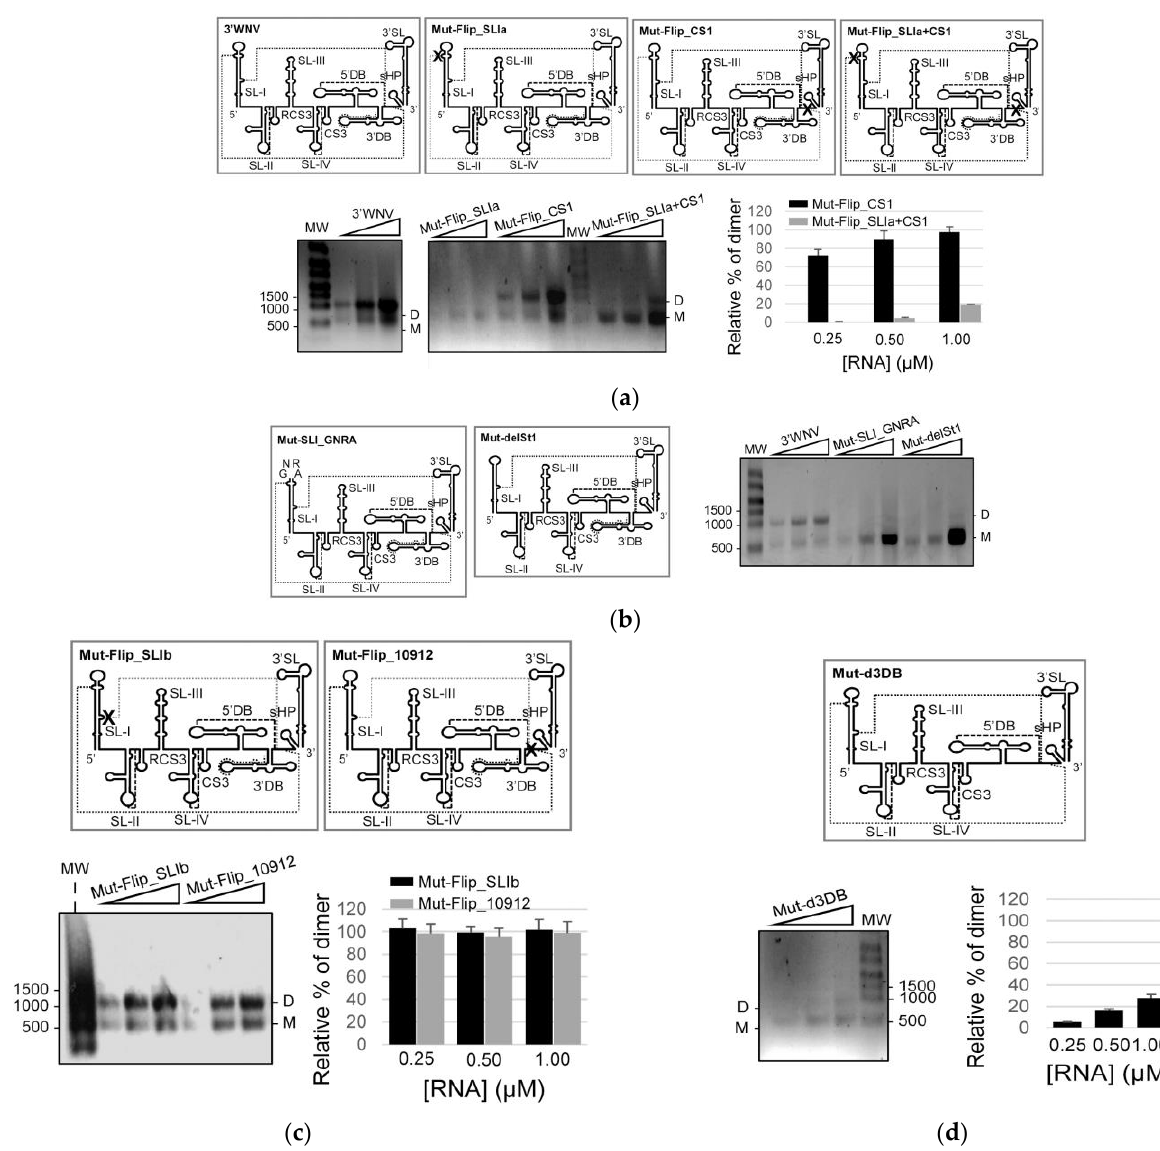
Figure 5. Specific sequences within the SL-I and the 3 ′ DB elements are involved in the formation of dimeric conformers. A collection of mutants bearing different sequence variations in SL-I ( a , b ), the single-stranded region placed at the 3 ′ end of the double-dumbbell elements ( c ) and the 3 ′ DB ( d ) were generated and monitored for their capacity to form dimers. Conformers were resolved as noted in Figure 4. Histograms show the dimer rate for each construct relative to that shown by 3 (cid:48) WNV RNA. Data are the mean of three independent experiments ± standard